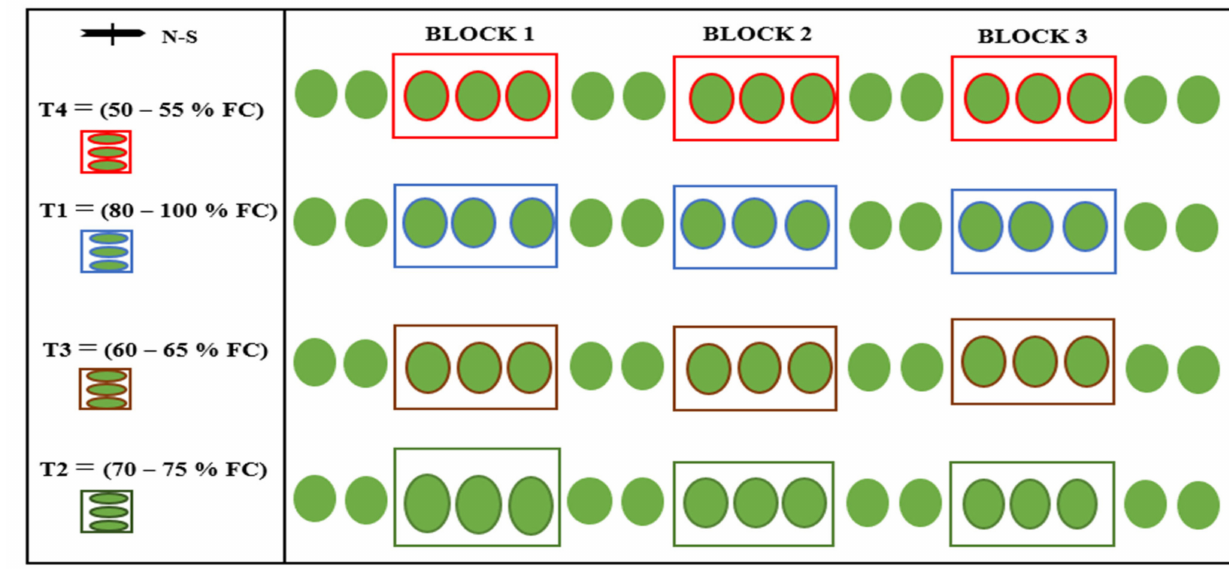
Figure 1. Field layout and experimental design.